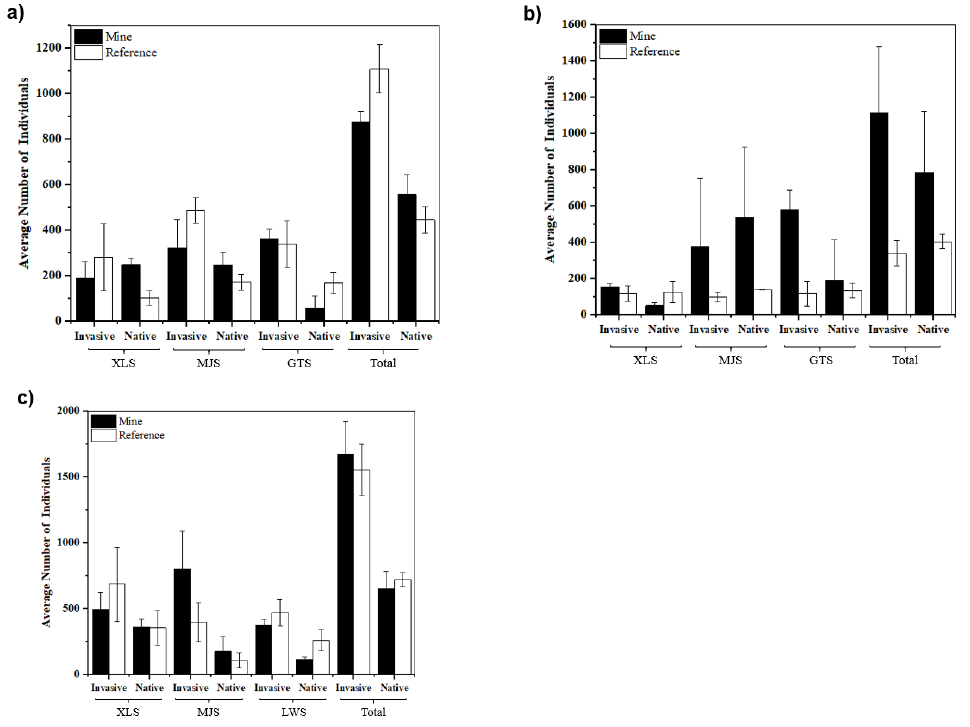
Figure 5. Comparison of average individual numbers of invasive plants and native plants in each sampling area for: ( a ) spring 2021 (April), ( b ) autumn 2021 (October), and ( c ) spring (April) 2022. There was a significant positive relationship between abundance in the mine site and abundance in reference sites for both native and invasive plants, where species that are relatively abundant are also abundant across sites (Figure 6). The total plant number and the plant species richness among the mine sites and reference sites were similar (Figure 3; Table 4). Overall, calcareous mine sites did not differ significantly in the proportion of individuals that are invasive compared to reference sites (Table 2a, p > 0.05). However, when the site pairs are considered together, we can find that the difference between the individual numbers of invasive plants and native plants in each sampling area is quite significant, and invasive plants have a higher abundance (Table 2b). The results from the chi-square tests showed that: in general, the abundance of invasive plants is slightly higher than that of native plants, but compared with calcareous areas and reference areas there was no obvious difference between the number of invasive plants and native plant species (Figures 3 and 4; Table 4). Looking at each sampling site separately, we found that, generally, the number of invasive plant species in all mine sites was higher than that of native plants, but in reference sites of GTS and XLS, the number of native plant species is slightly higher than that of invasive plants. Among the four sampling sites, only the num- ber distribution of invasive plants and native plant species in GTS is different, while the number of invasive plants and native plant species in other sampling sites is not signifi- cantly different (Table 3).